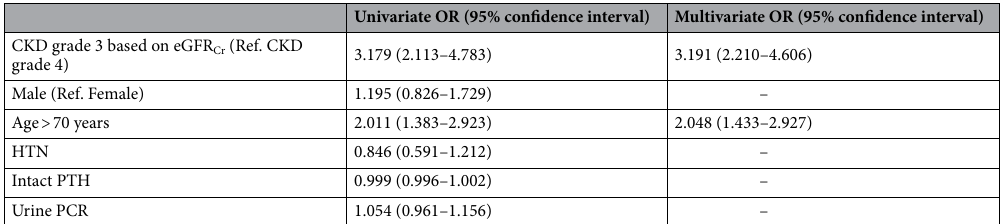
Table 2. Logistic regression analysis of the high difference between the eGFR Cr and eGFR CysC . Excluding patients with missing values, a total of 557 (87.2%) patients were included in multivariate logistic regression model. CKD Chronic kidney disease, eGFR Estimated glomerular filtration rate, eGFR Cr eGFR based on creatinine,